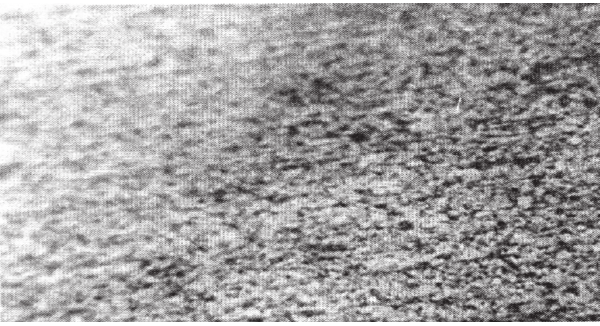
Figure 4. Micrograph of welded sample subjected to current I processing (×100).